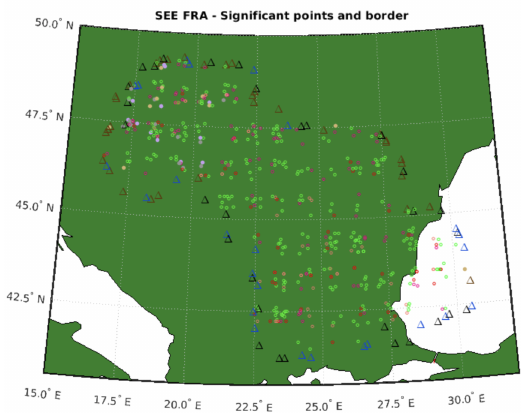
Figure 4. SEE FRA significant